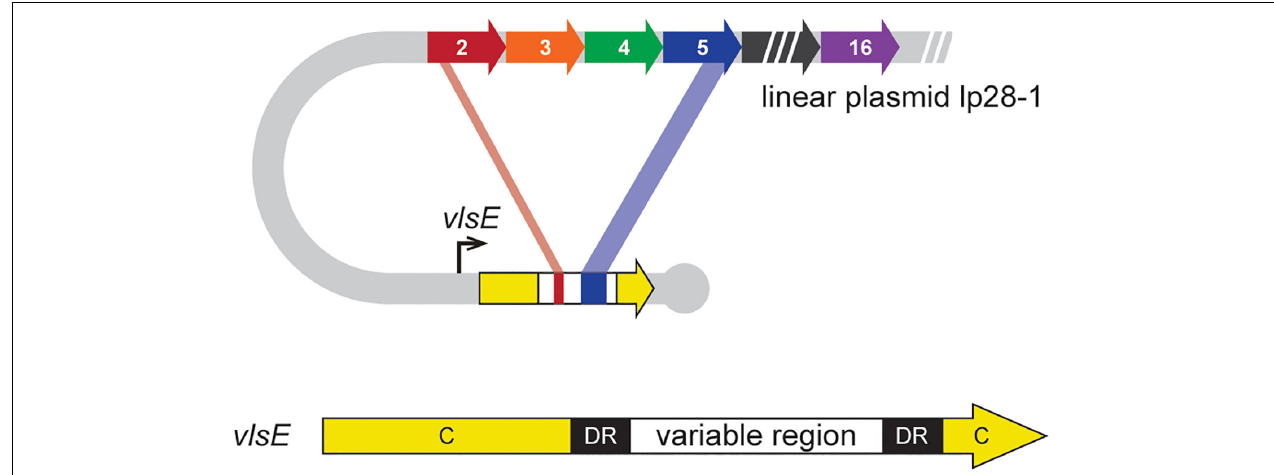
FIGURE 1 | Schematic of DNA rearrangements underlying antigenic variation in B. burgdorferi. The vls locus is located near the right hairpin telomere on lp28-1 (Zhang et al., 1997). It is composed of an expression locus ( vlsE) that contains a variable region flanked by 17-bp direct repeats (DR) and constant regions (C). Upstream of vlsE are 15 homologous, but different, silent cassettes corresponding to the variable region of vlsE , which carry information for unidirectional segmental gene conversion events to generate chimeric VlsE antigens (Norris, 2014; Chaconas et al., 2020). Figure modified from Verhey et al.